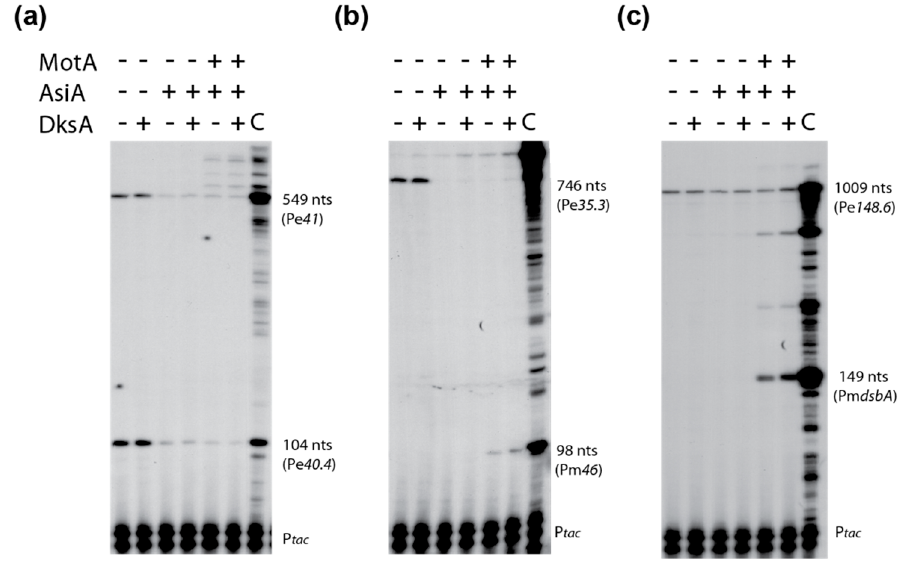
Figure 5. Presence of DksA has no effect on transcription from various T4 Pe’s in vitro. Representative gels show primer extension products for Pe40.4 ( a ), Pm 46 ( b ), and Pm dsbA ( c ) arising from in vitro transcription of T4 wt DNA in the presence of DksA, MotA, and/or AsiA, as indicated. Each primer extension reaction also contained P tac RNA and its primer as an internal control. In vivo RNA isolated from a T4 wt infection of B606 wt at 5 min post-infection was used as a positive control for each primer (labeled as lane C). The lengths of primer extension products are indicated in nt.